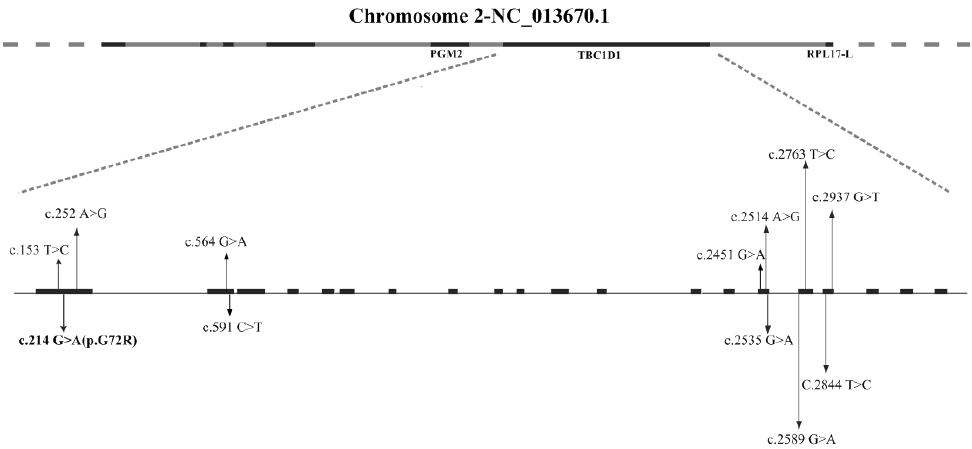
Figure 1. Schematic illustration of rabbit TBC1D1 gene organization and the identified genetic variants. Black bars represent the 20 exons. The inverted arrows indicate location of identified variants in the present study. Bold arrow at c.214 represents non-synonymous mutation, whereas the others indicate the synonymous